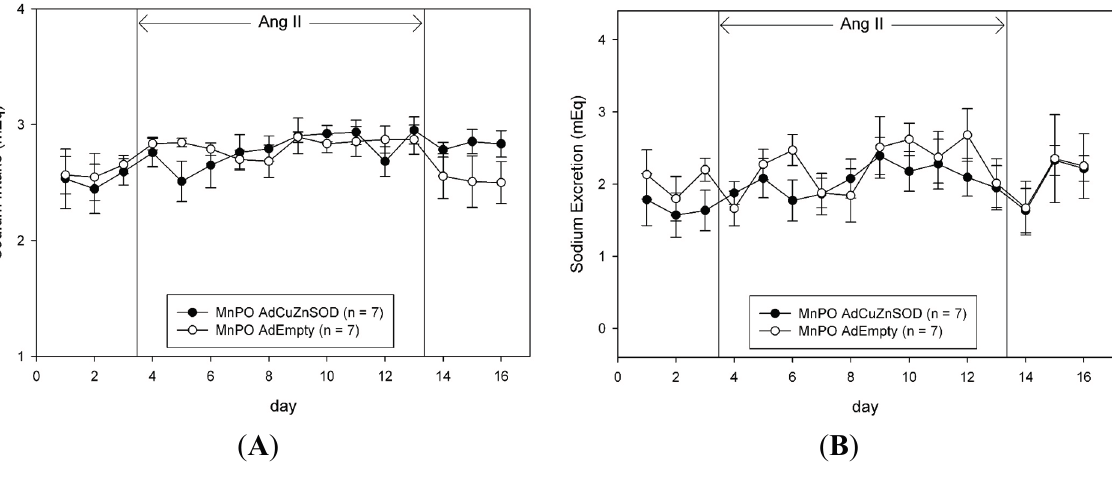
Figure 3. Average 24-h sodium intake ( A ); sodium output ( B ); and sodium balance ( C ) during saline infusion (3 days of control and recovery period) and 10 days of Angiotensin II (AngII) infusion in rats that were MnPO injected with AdCuZnSOD or